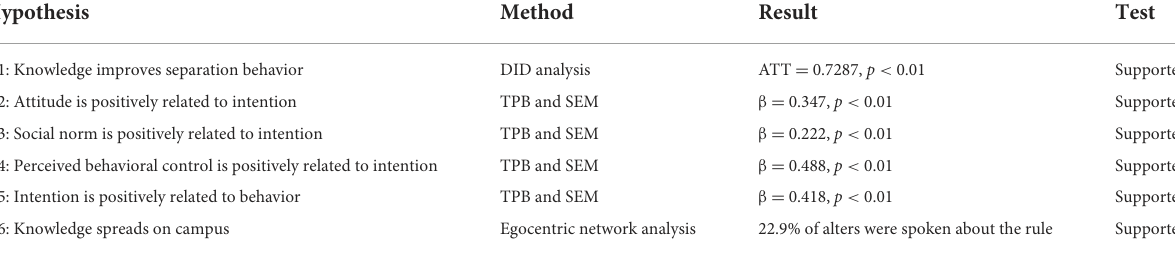
TABLE 7 Synthesis of hypotheses